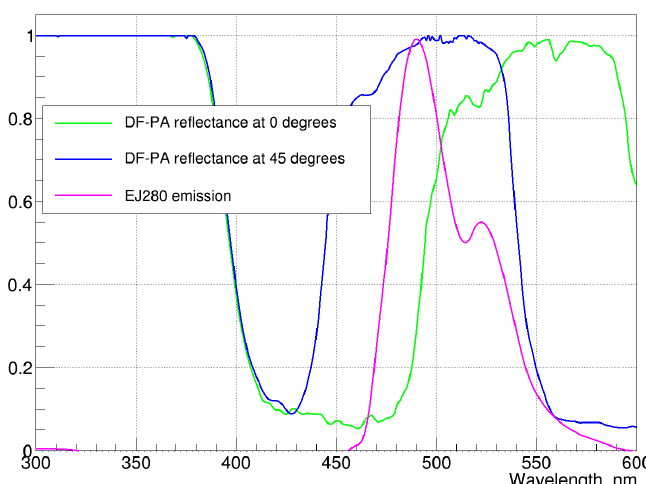
Figure 5. WLS emission spectrum [17] (in a.u.) and the dichroic mirror reflectance fully overlap for angles above certain value between 0 and 45 degrees, and partially below. About 30% of the emitted light is lost.